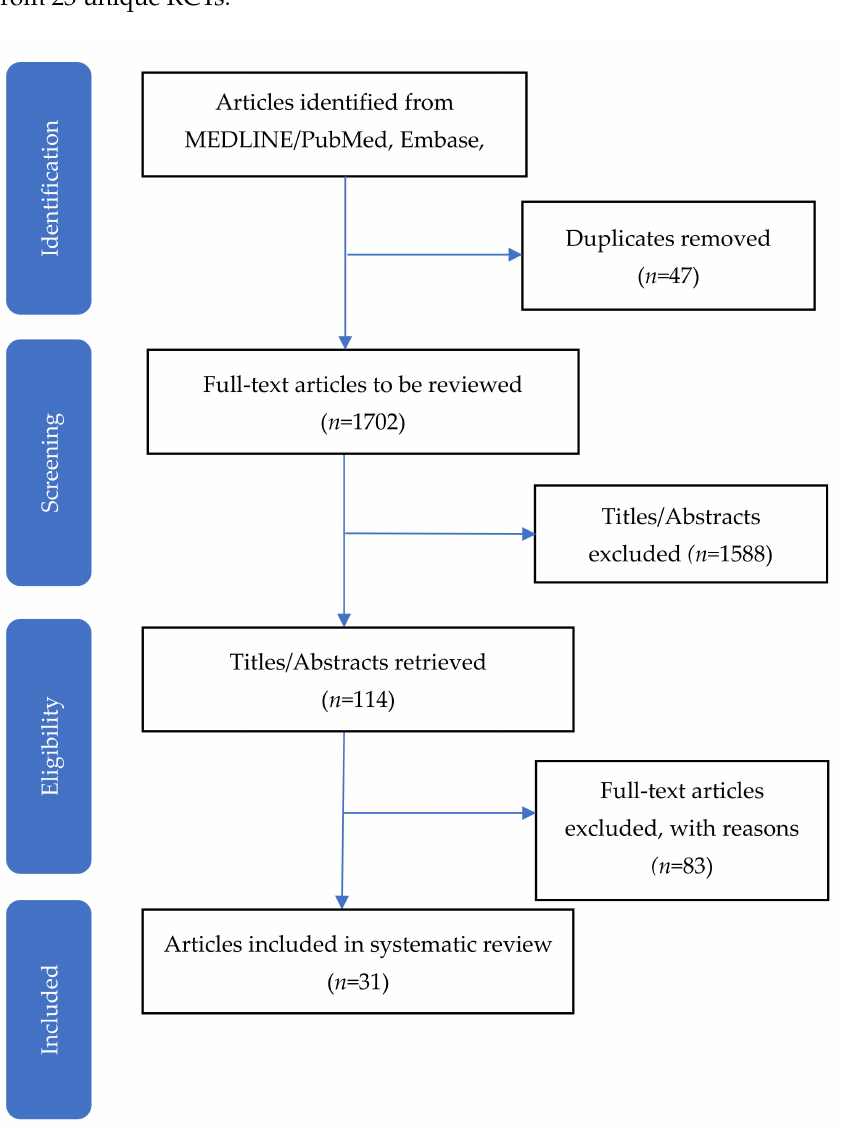
Figure 1. Preferred reporting items for systematic reviews and meta-analysis (PRISMA) flow chart for the selection of